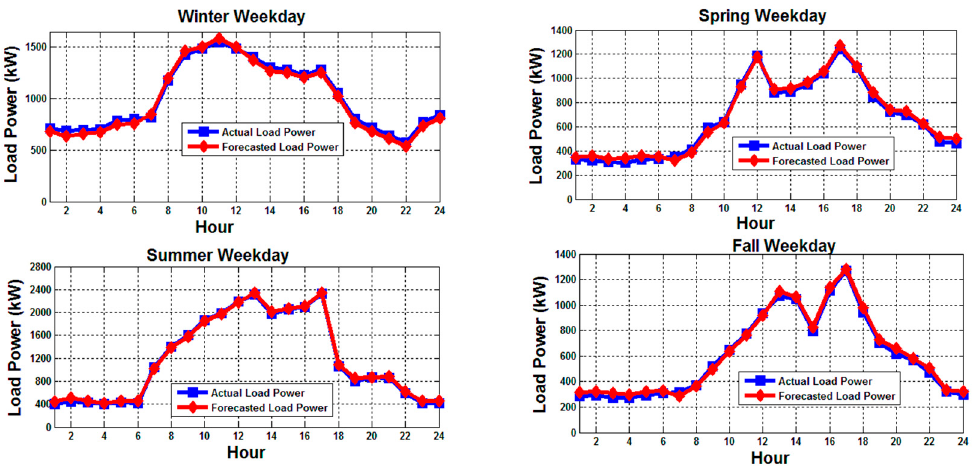
Figure 11. Real vs. forecasted electricity demand for weekdays.